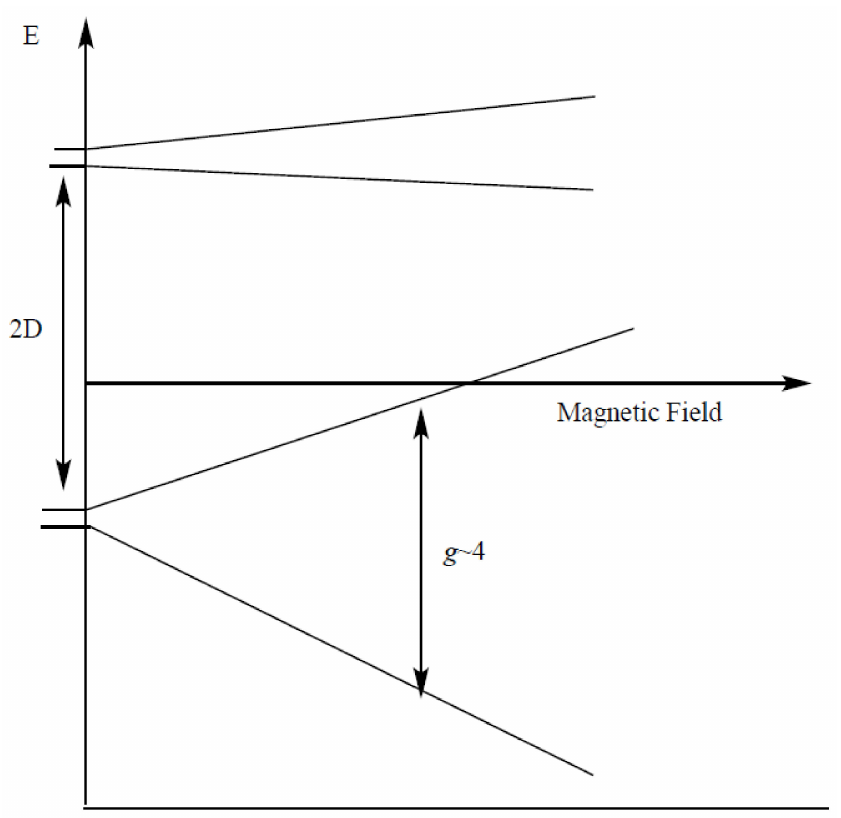
Figure 2. The axial spin 3 state ZFS and the Zeeman splitting when the field is perpendicular to the 2 molecular